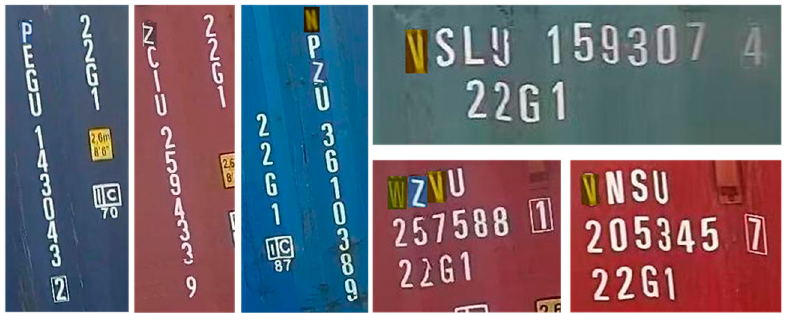
Figure A1. Some images of the self ‐ built dataset in this paper.